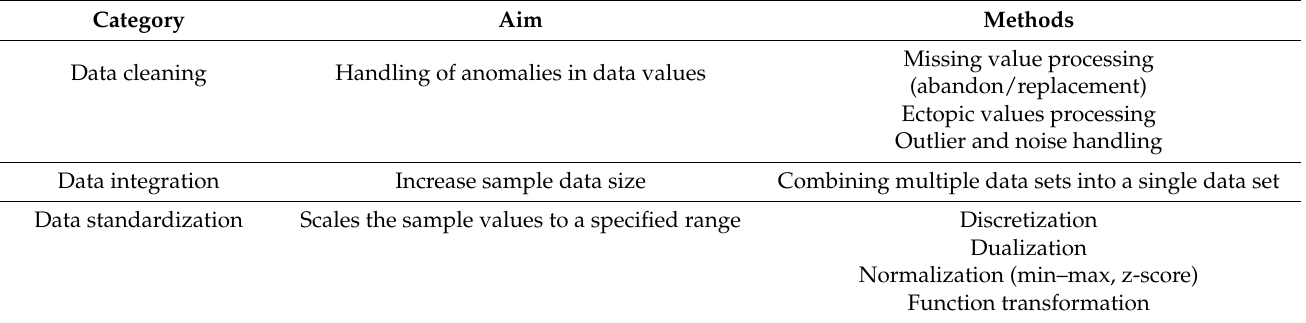
Table 1. Data pre-processing